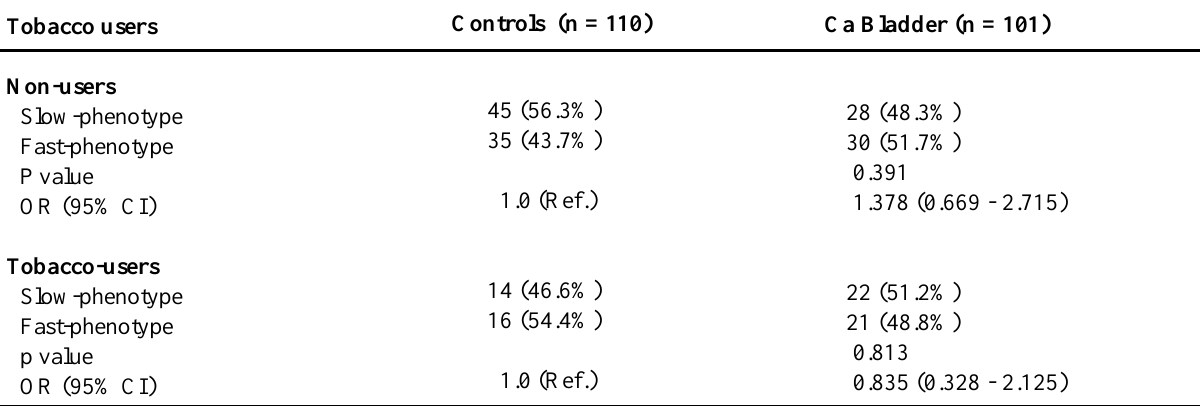
Table 2 – Risk of bladder cancer according to combination of NAT2 genotypes with tobacco users.